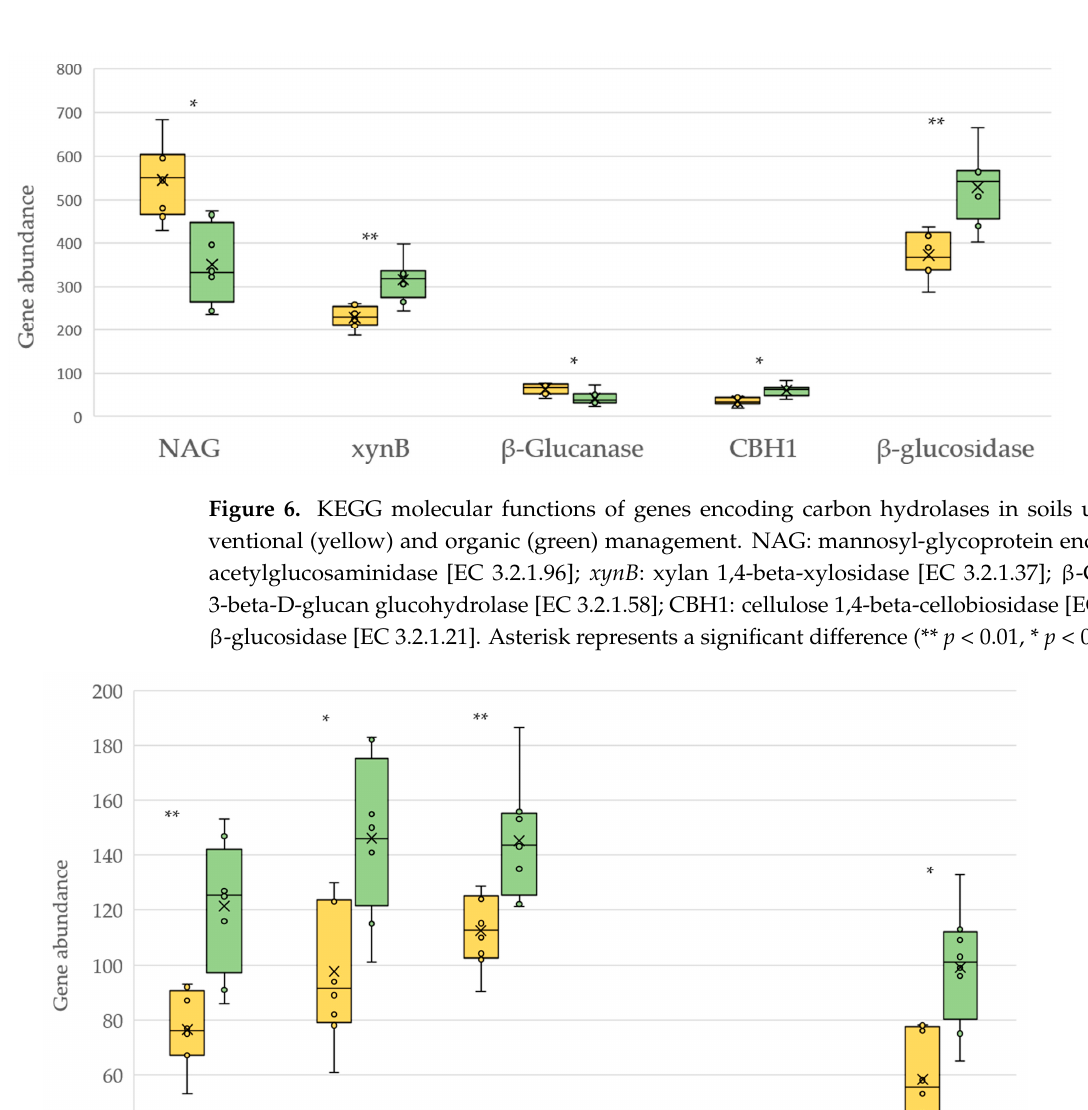
The bacterial production potential of hydrolase and oxidoreductase enzymes related